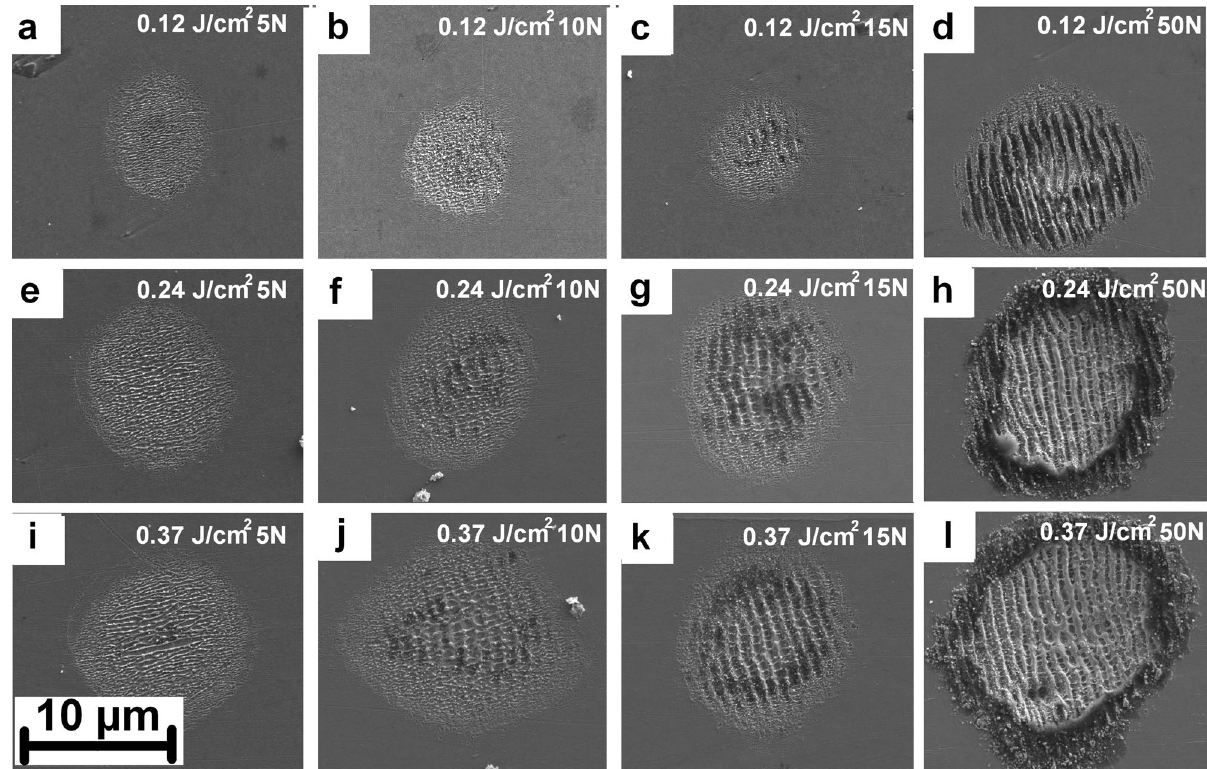
Figure 3. LIPSS evolution with the fluence and number of pulses (N).